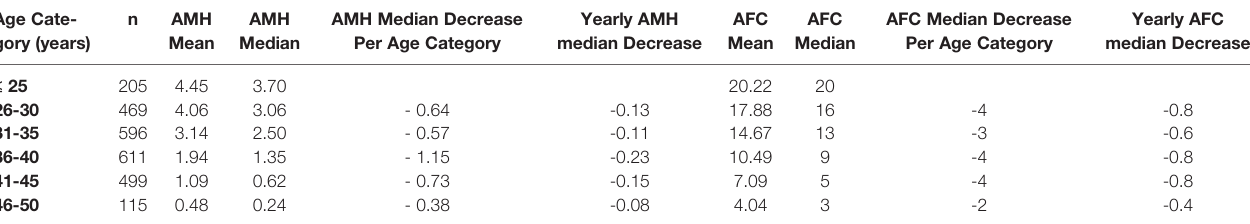
Bold values are the age